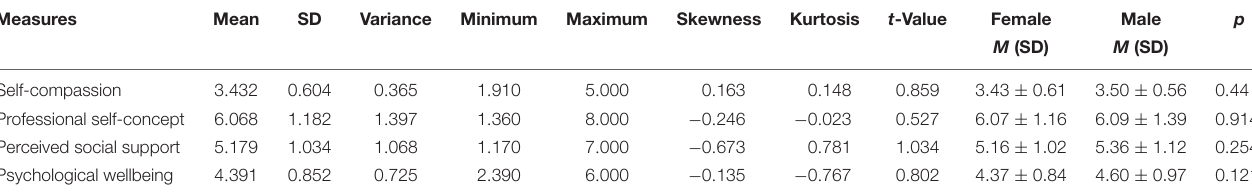
TABLE 1 | Descriptive statistics for variables.